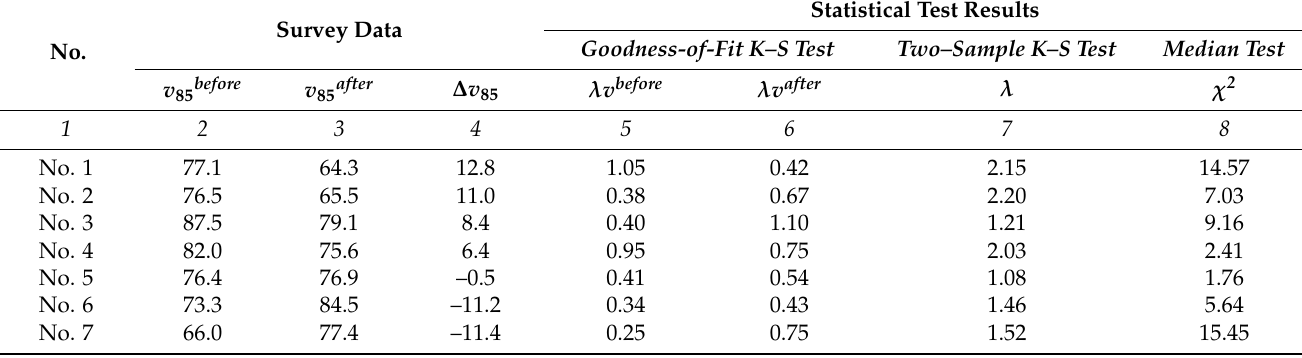
Table 4. Results of standard statistical tests on test in study area No. 3 with 50 km/h speed limit and central islands installed (in relation 85th percentile speed). Goodness-of-fit K–S test and Two–sample K–S test λ α = 1.36 ( α = 0.05), Median test χ α 2 = 3.84 ( α =